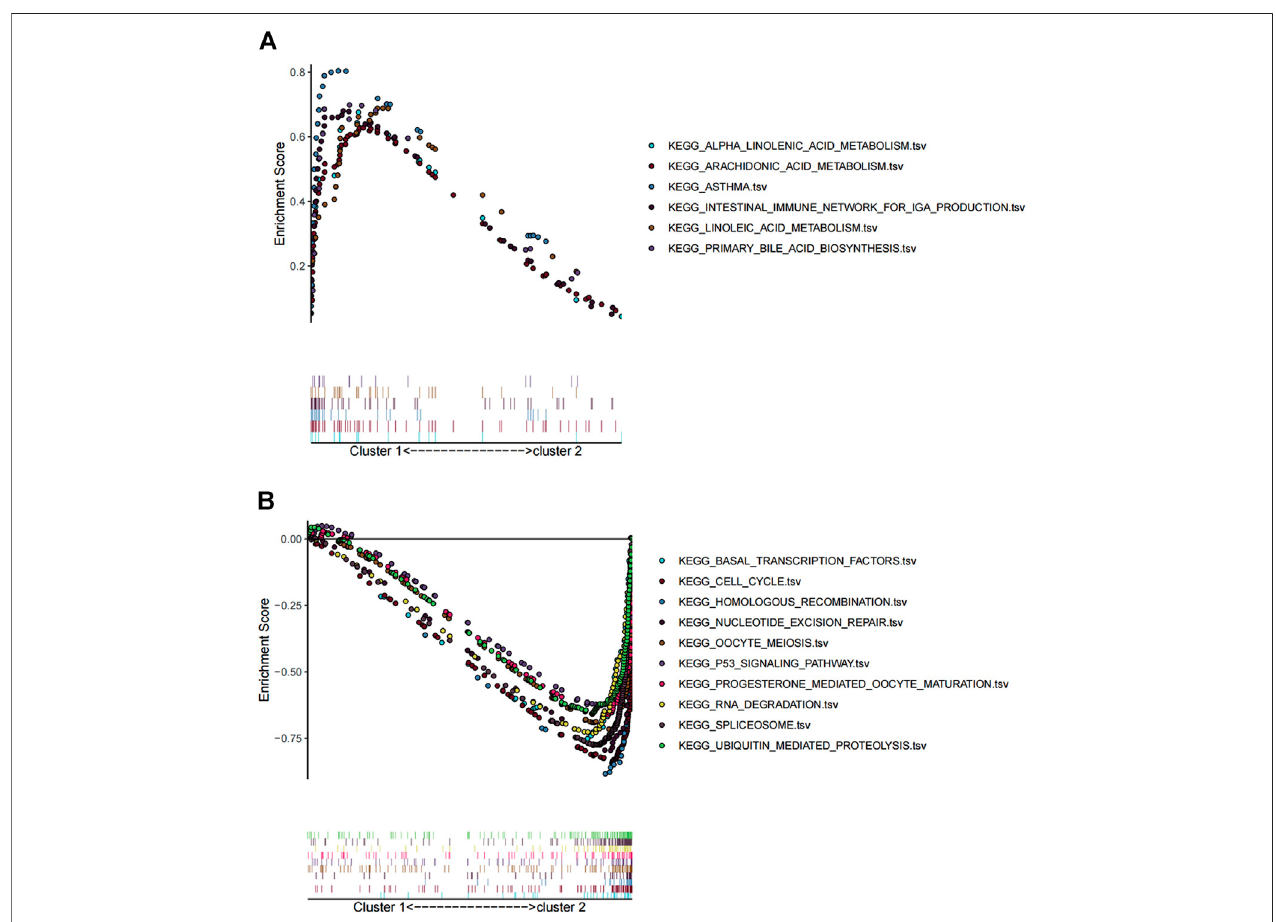
FIGURE 3 | GSEA analysis of differentially expressed genes between cluster 1 and cluster 2. (A) KEGG analysis of upregulated pathway in cluster 1 and (B) downregulated pathway in cluster 2.